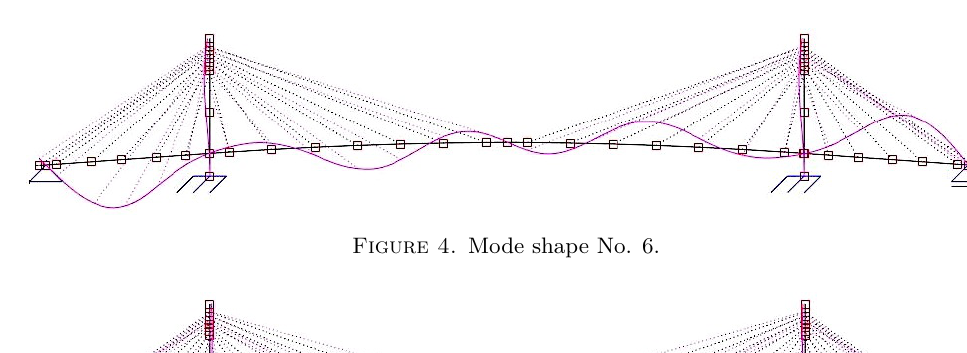
Figure 3. Mode shape No. 5.